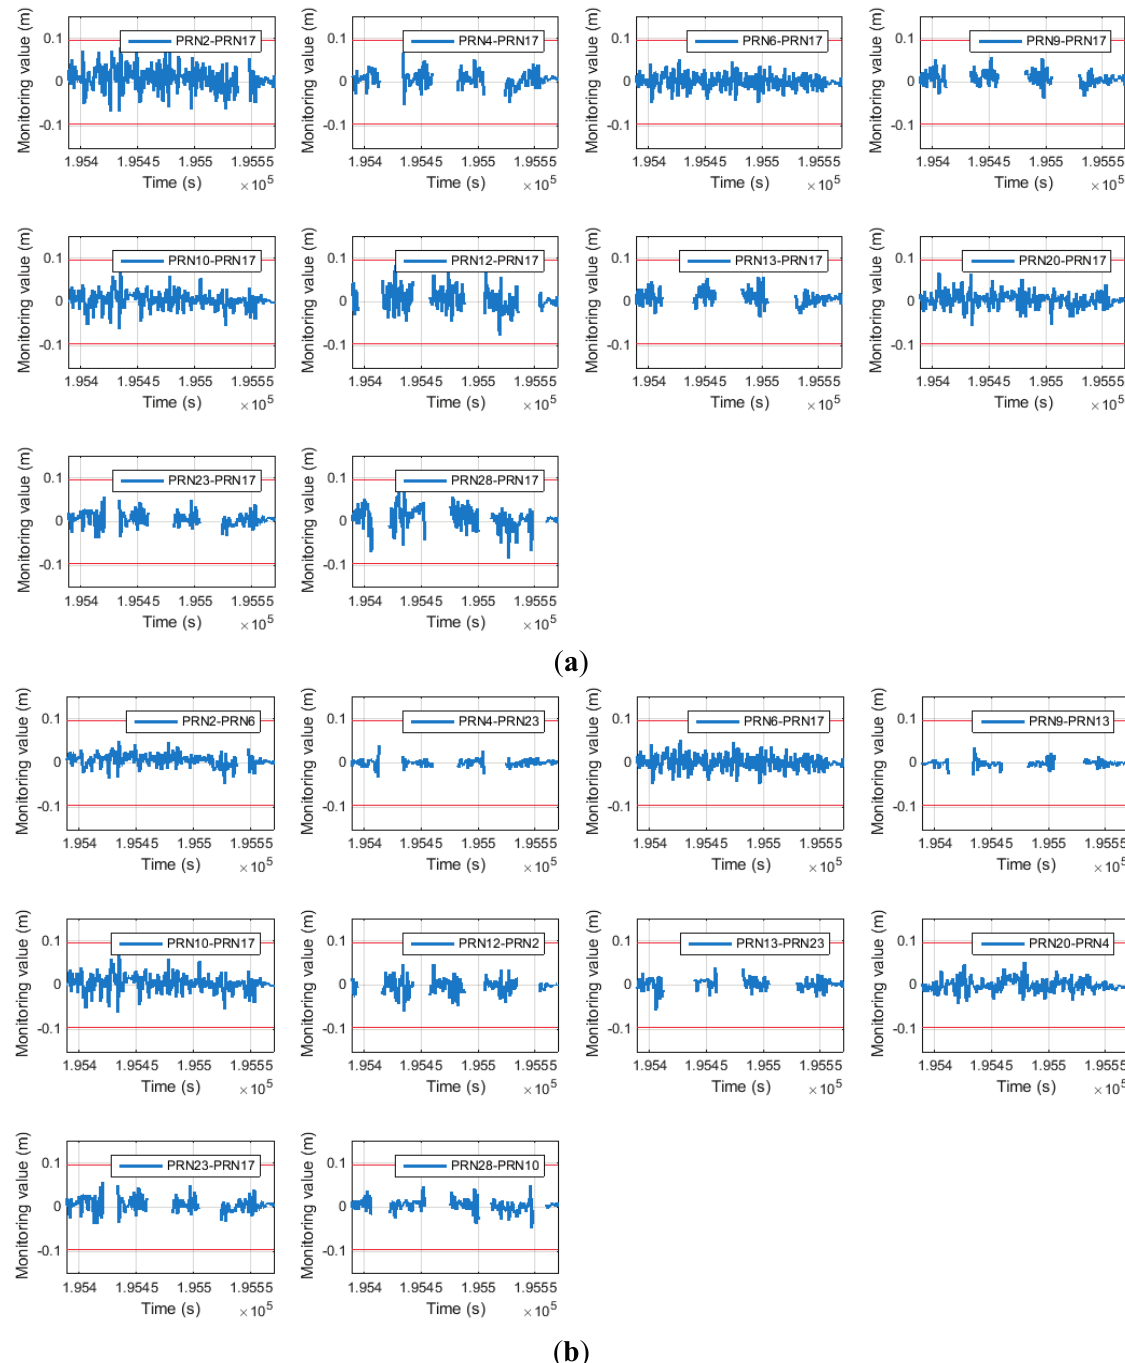
Figure 18. ( a ) Monitoring value error of general SD (above); ( b ) monitoring value error of proposed SD